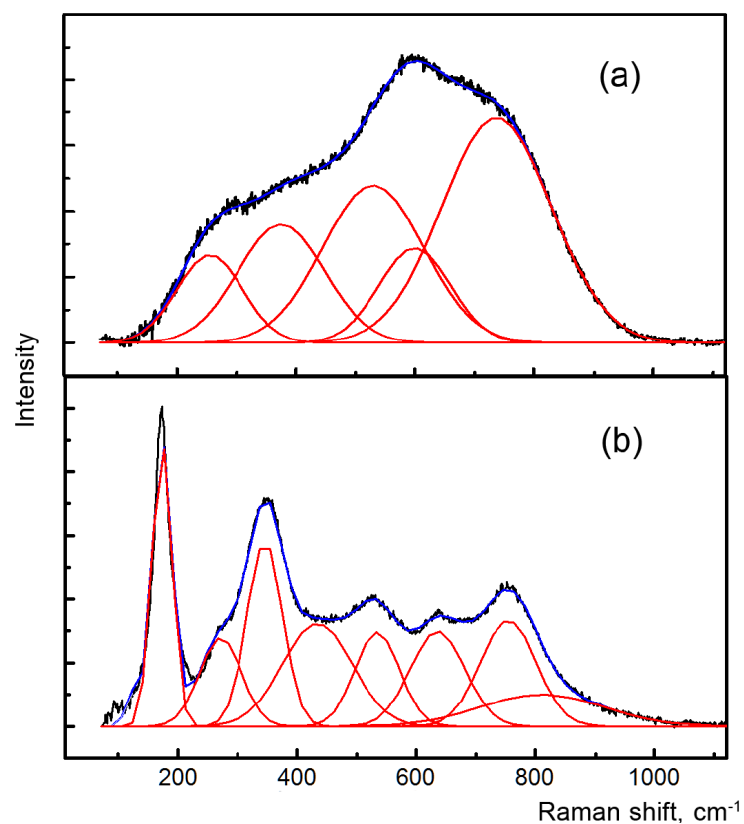
Figure 3. Raman spectra of the metamict ( a ) and annealed brannerite ( b ). Table 3. Raman bands and their assignment in the annealed studied brannerite sample and the reference data from